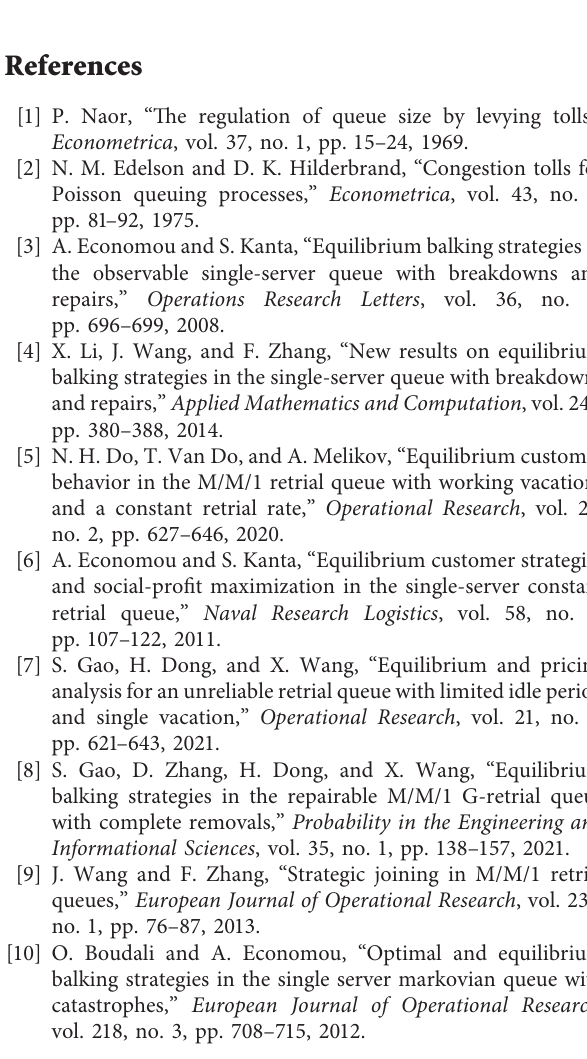
) and T ( n ) vs. λ U L